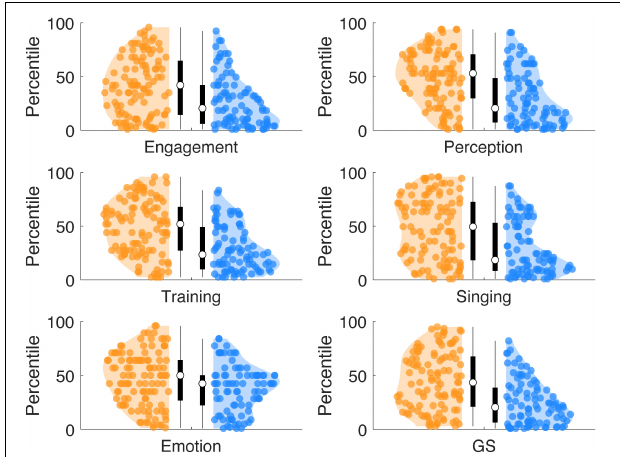
FIGURE 4 | Percentiles of musical sophistication scores with respect to an English-speaking norm population. High synchronizers show a similar distribution compared to an English-speaking norm population, with the median around the ∼ 50 percentile. In contrast, low synchronizers showed lower scores of musical sophistication at all scales, with the median in the lower percentiles ( ∼